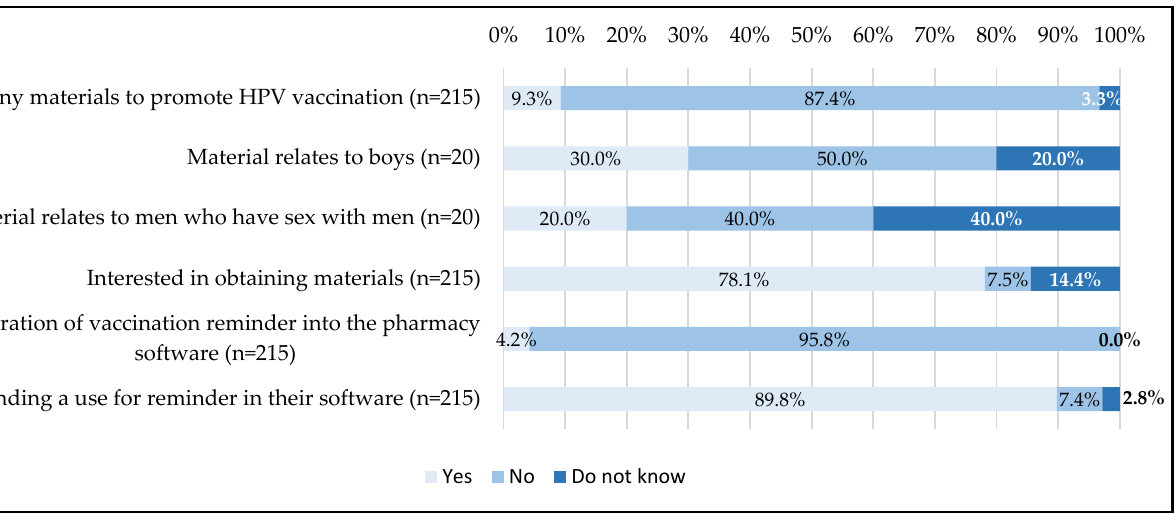
Figure 3. Pharmacists’ use and interest in materials and aids for HPV vaccination promotion.